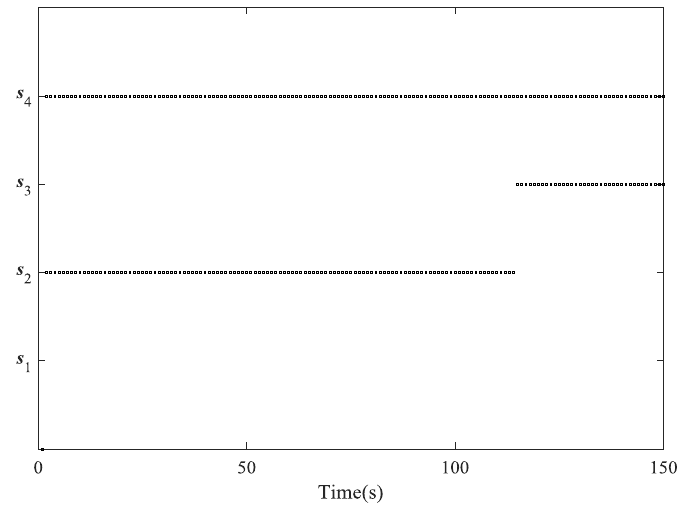
Figure 7. Sensor selection at each time step.